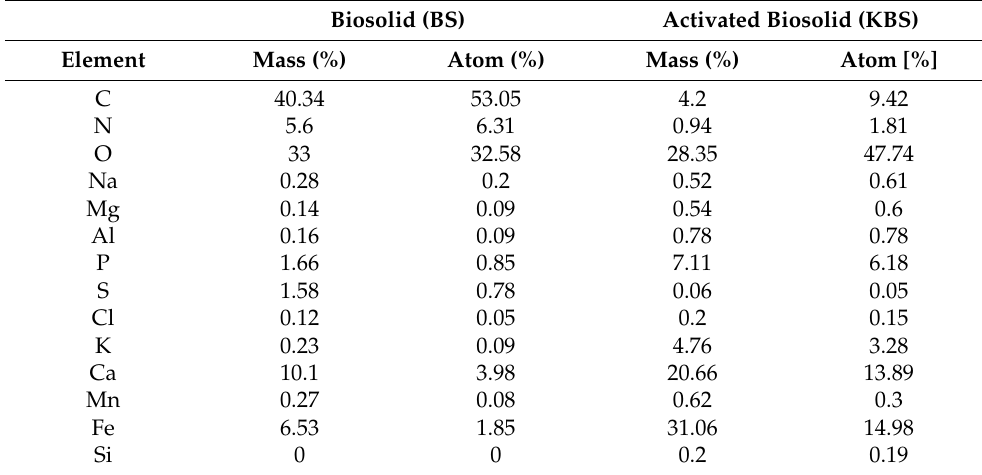
Figure 1. SEM images of Biosolids; ( a ) pristine (BS), ( b ) activated samples (KBS) in different magni- fications. Table 2. EDS microanalysis of elements on the surface of BS and KBS.